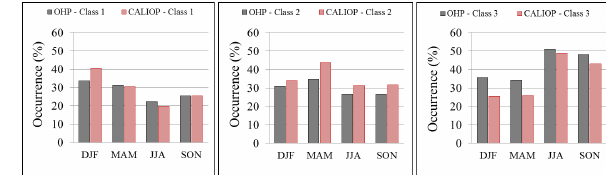
Figure 7. Seasonal cirrus clouds occurrence over the OHP site according to the different cirrus clouds classes. Panels A, B, C represent the class 1 (thin cirrus in middle troposphere), 2 (thick cirrus in upper troposphere) and 3 (thin cirrus in upper troposphere) respectively. For each histogram, the gray bars represent the results obtained from the OHP lidar data and the red bars those derived from the CALIOP data.